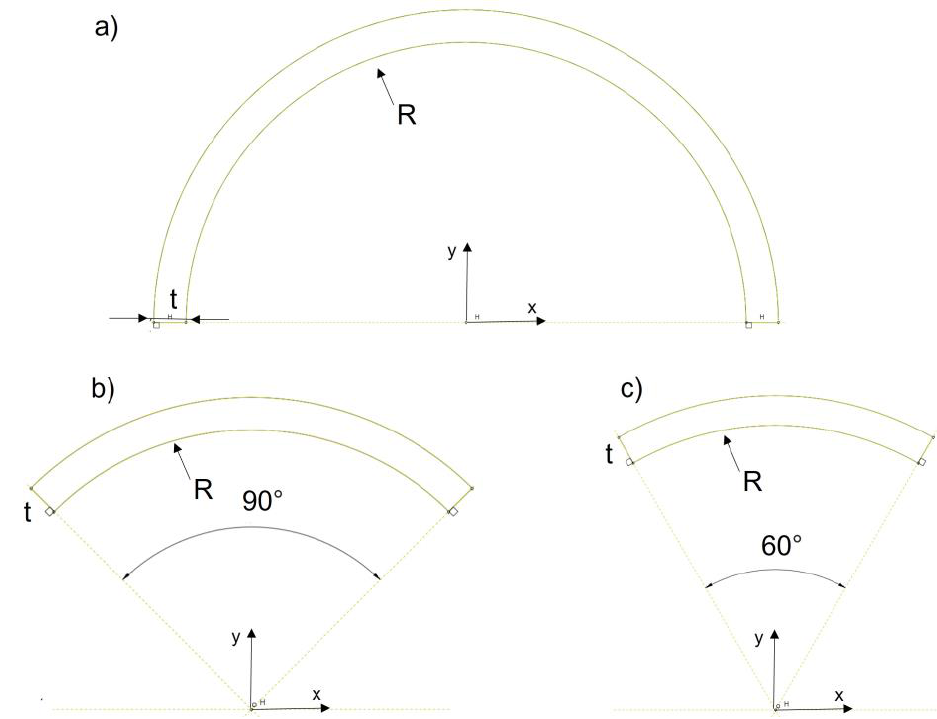
Figure 3. Cross-sections of the columns, ( a ) 180 °C-section, ( b ) 90 °C-section, ( c ) 60